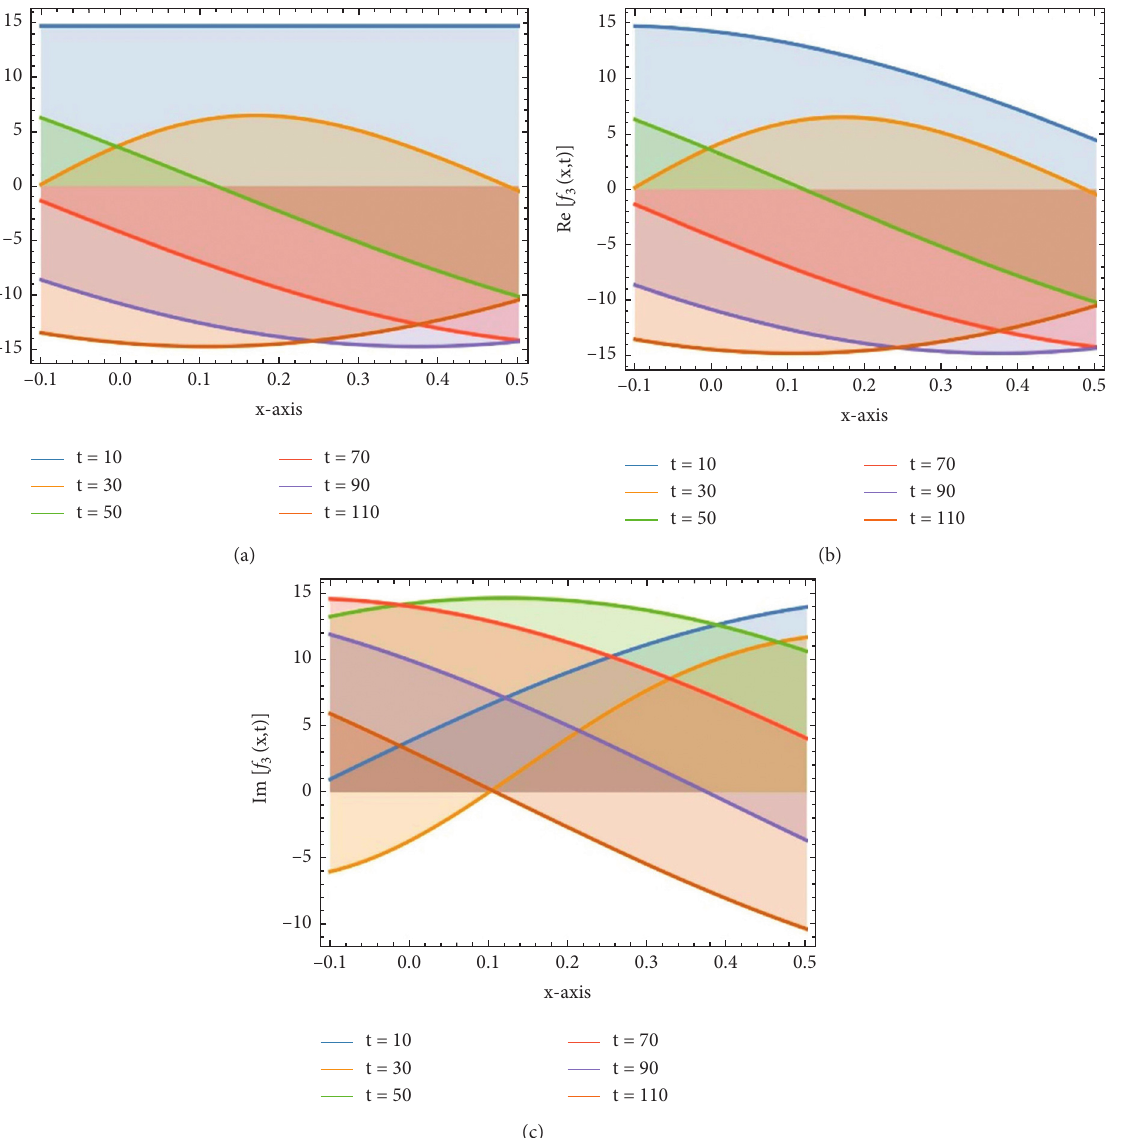
Figure 2: Optical soliton wave solutions of the absolute (a), real (b), and imaginary (c) value of equation (8) in two-dimensional view when � 9, ϑ � 0 . 5, c � − 9, c � 4, and h � ( θ � 1, α � − 1, μ � 4, c 1 2 3